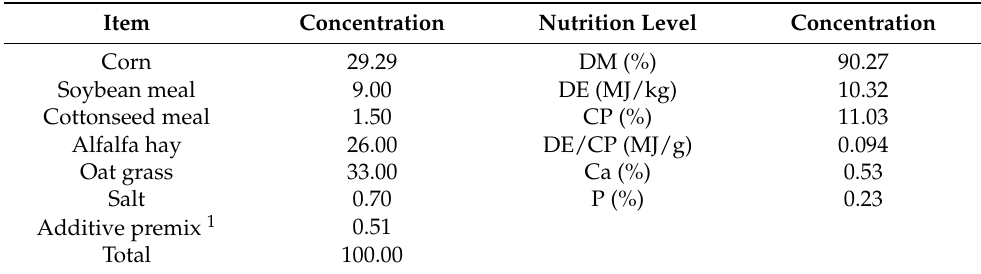
Table 2. Test diet composition and nutrient level (dry matter basis, DM